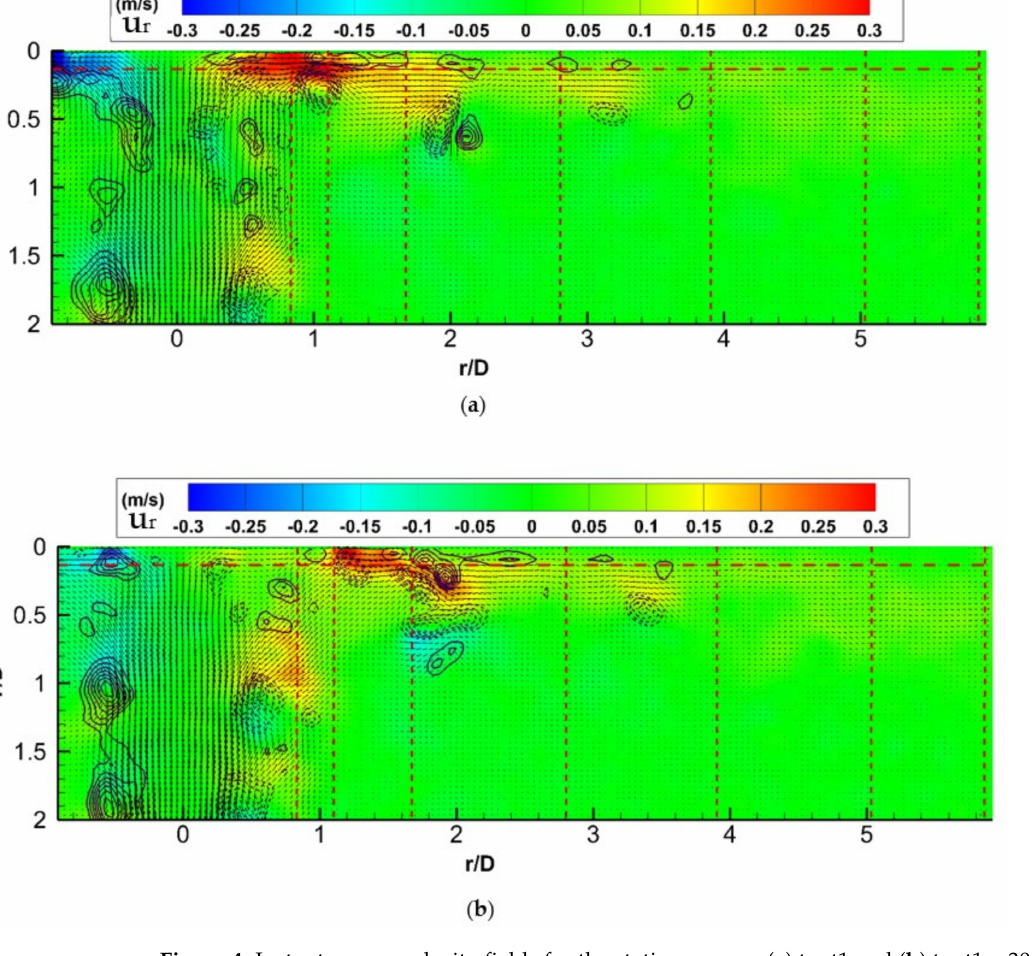
Figure 4. Instantaneous velocity fields for the stationary case ( a ) t = t1 and ( b ) t = t1 + 30